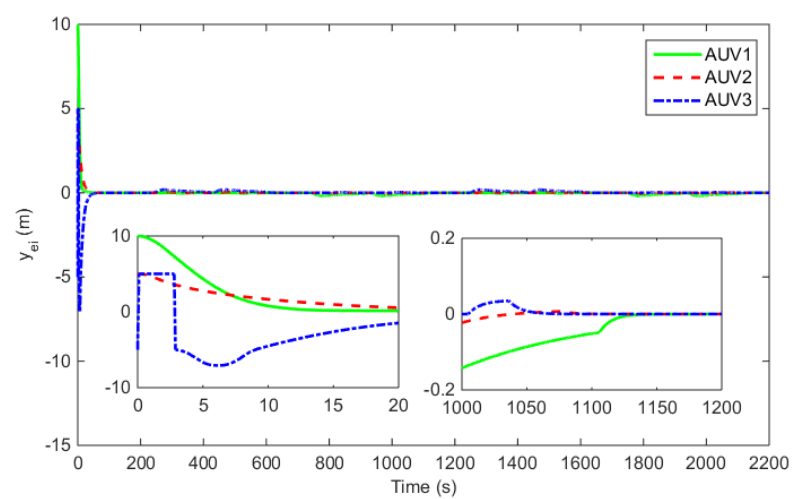
Figure 8. Cross-maneuvering errors of three AUVs.